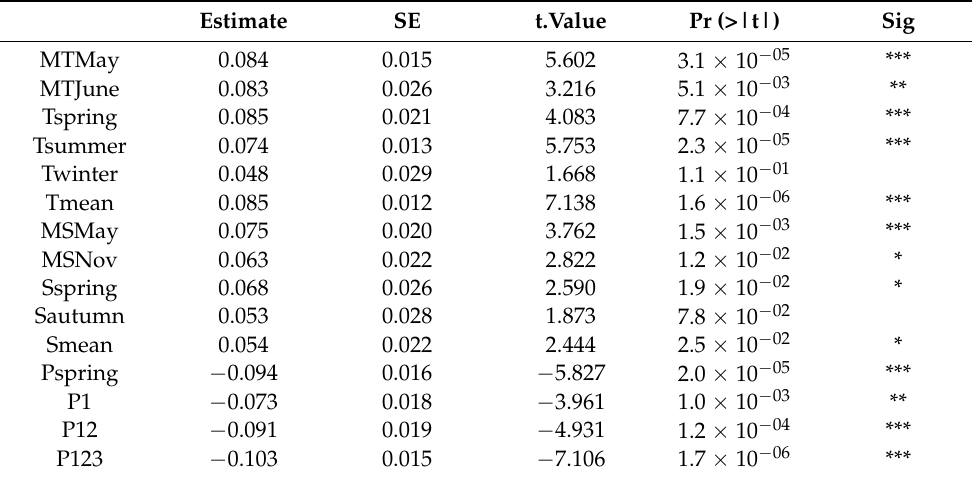
Table 3. Coefficients (SE) of important climate variables based on the PLS models.